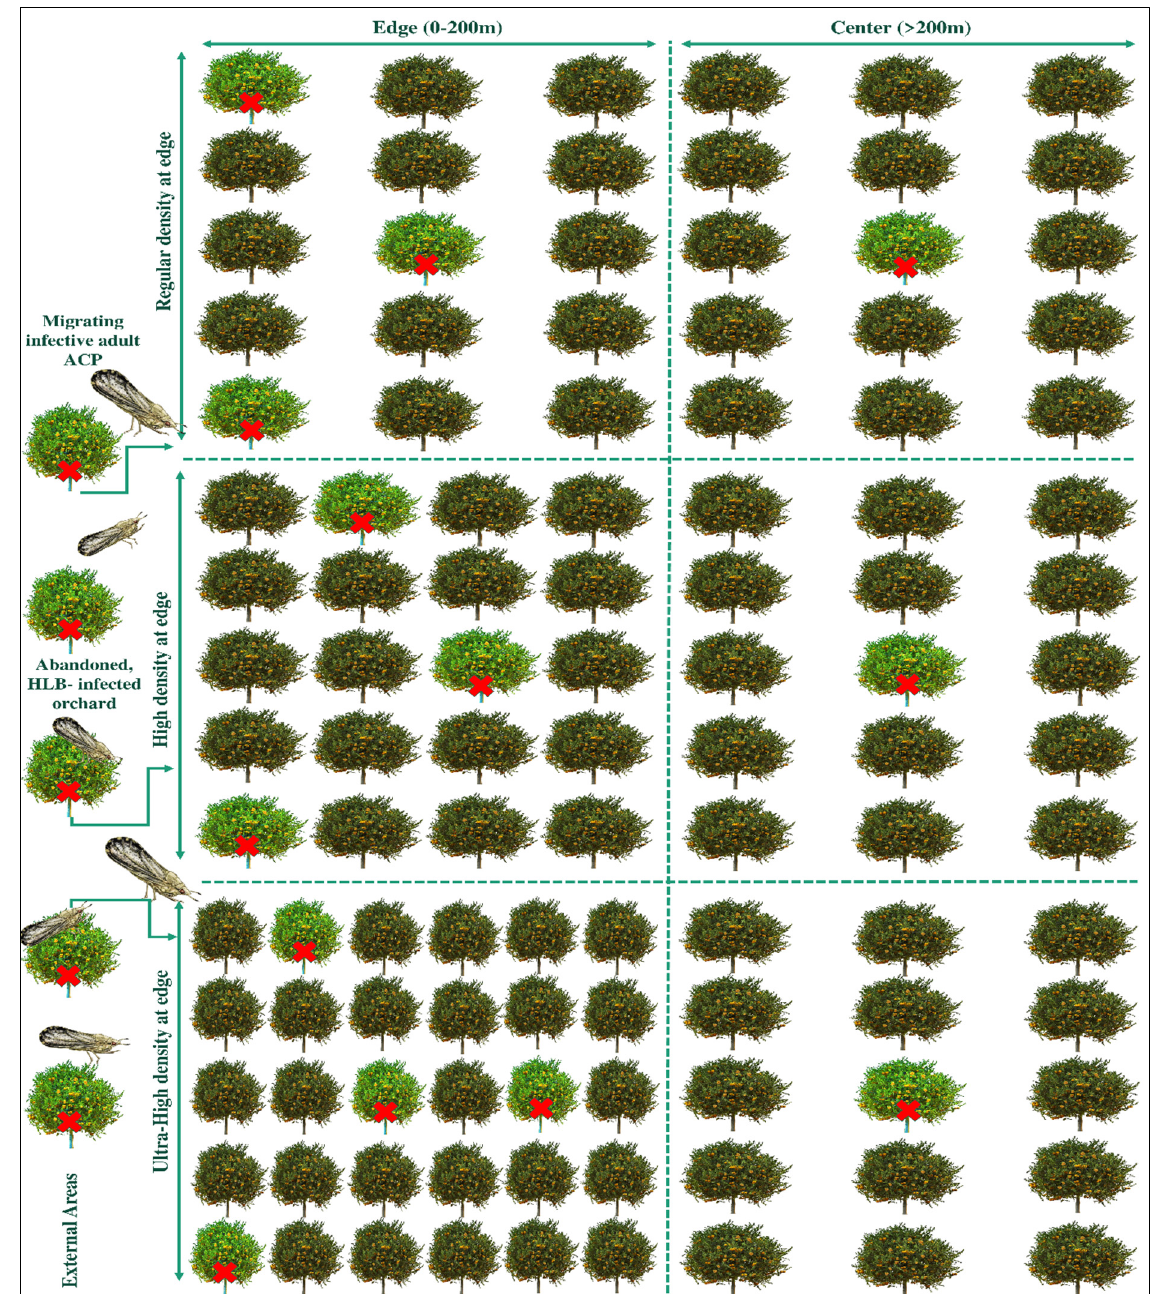
Figure 12. The effect of high tree density along the edge of well-managed orchards on citrus greening spread is depicted schematically. The orchards are mostly affected from the outside by a carrier psyllid vector. The high planting around the orchards may act as a temporary barrier for movement of ACP, resulting in a larger ratio of healthy to infected trees (dilution effect).